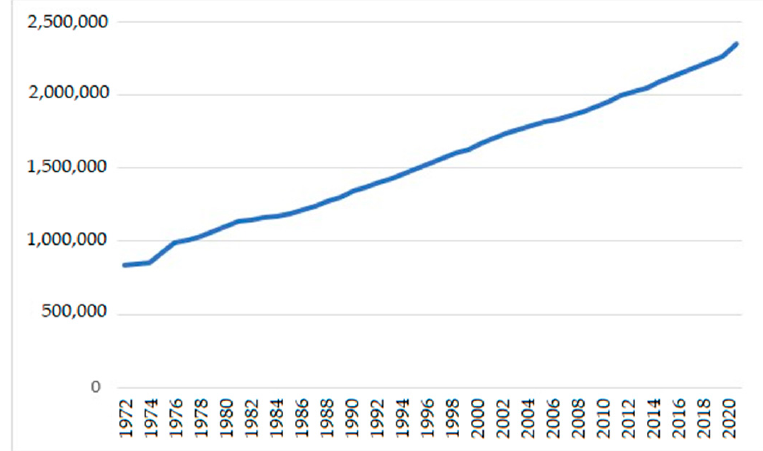
Figure 1. Evolution of the population aged 65 and over in Portugal [13].